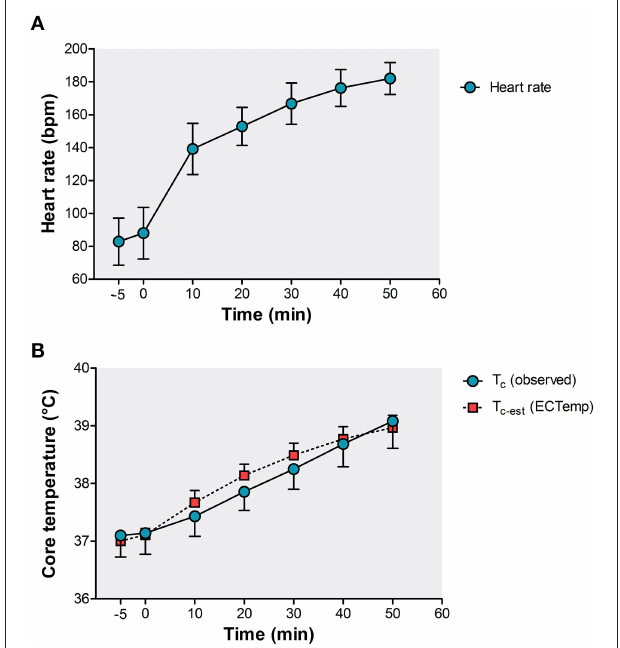
FIGURE 1 | Exercise-induced responses in (A) heart rate and (B) observed T c (temperature capsule, blue circles) and estimated T c − est (ECTemp TM algorithm, red squares). Data is presented as mean ±